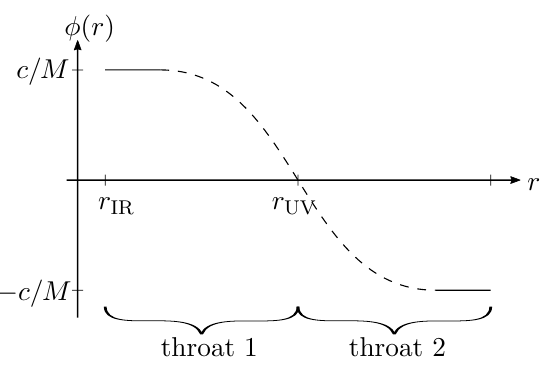
Figure 6 . The expected pro(cid:12)le of the 10d/5d mode along the radial